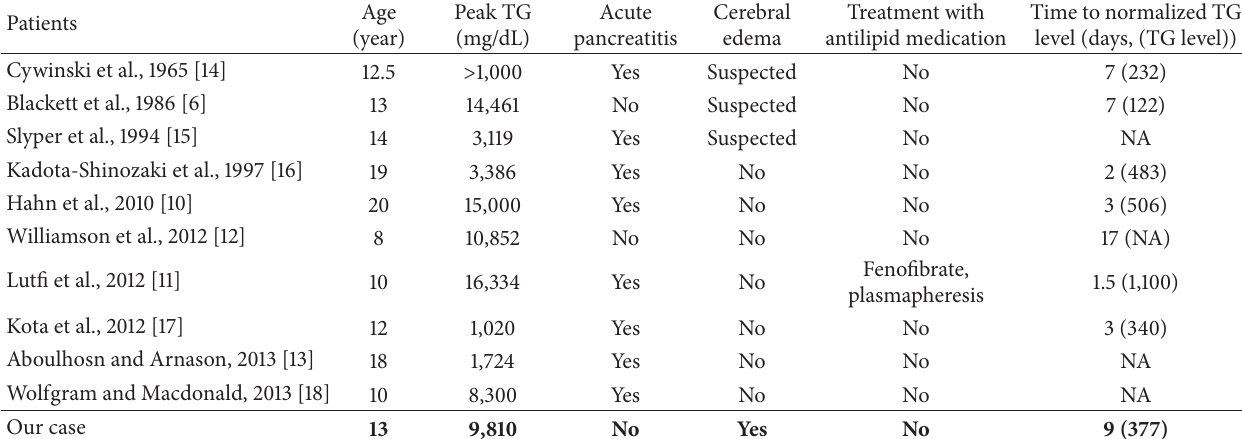
Table 1: Literature review of pediatric DKA patients with hypertriglyceridemia.